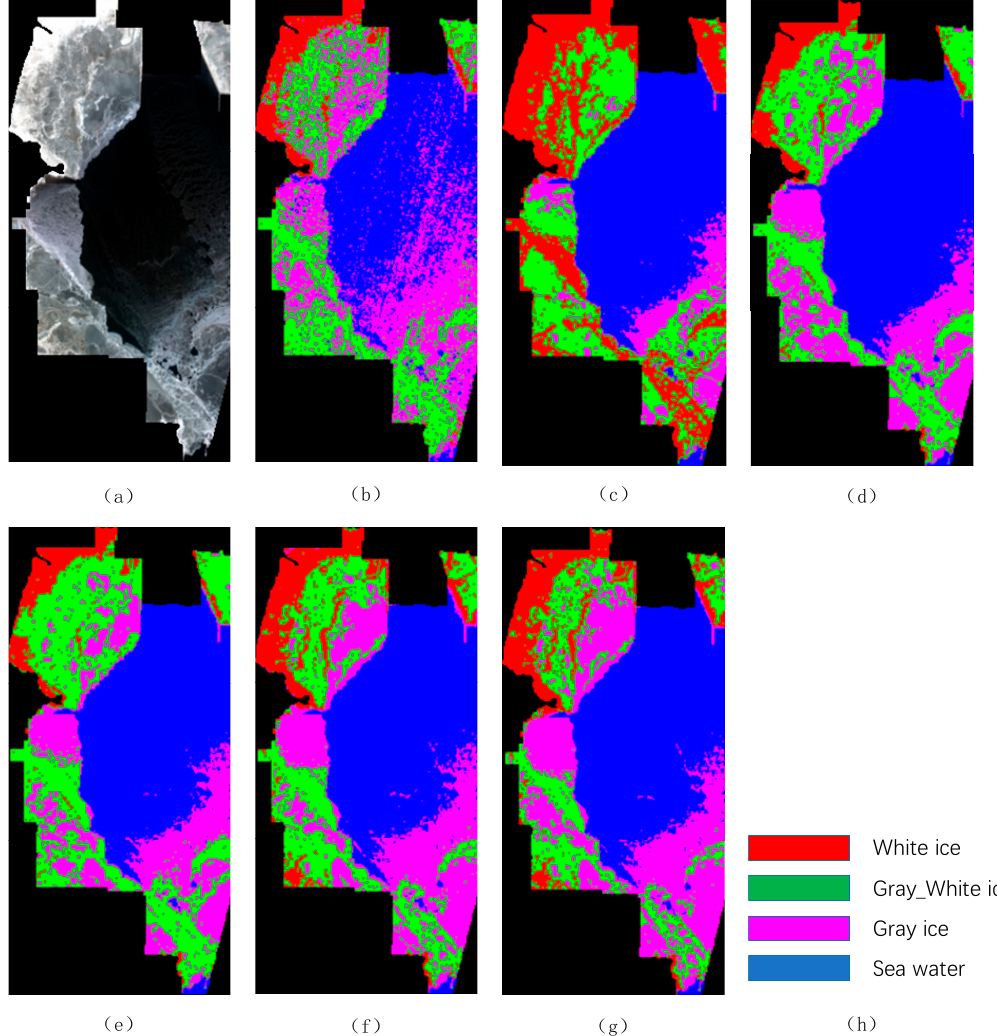
Figure 4. Classification maps of the Bohai Bay data set: ( a ) False-color composite; ( b ) SVM; ( c ) 1D-CNN; ( d ) 2D-CNN; ( e ) 3D-CNN; ( f ) GLCM-CNN; ( g ) Proposed; ( h ) class legend of Bohai Bay image.